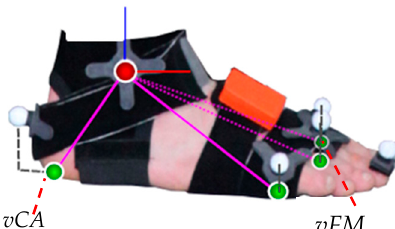
Figure 3. Foot model with optical markers and the four projected virtual contact points (green spheres) used for both the six degrees of freedom segment kinematics estimation and the IMU based gait event-detection. The virtual CA (vCA) marker and the virtual FM (vFM) marker, which were used for the event-detection in the IMU system, are denoted. The figure has been taken from [37].